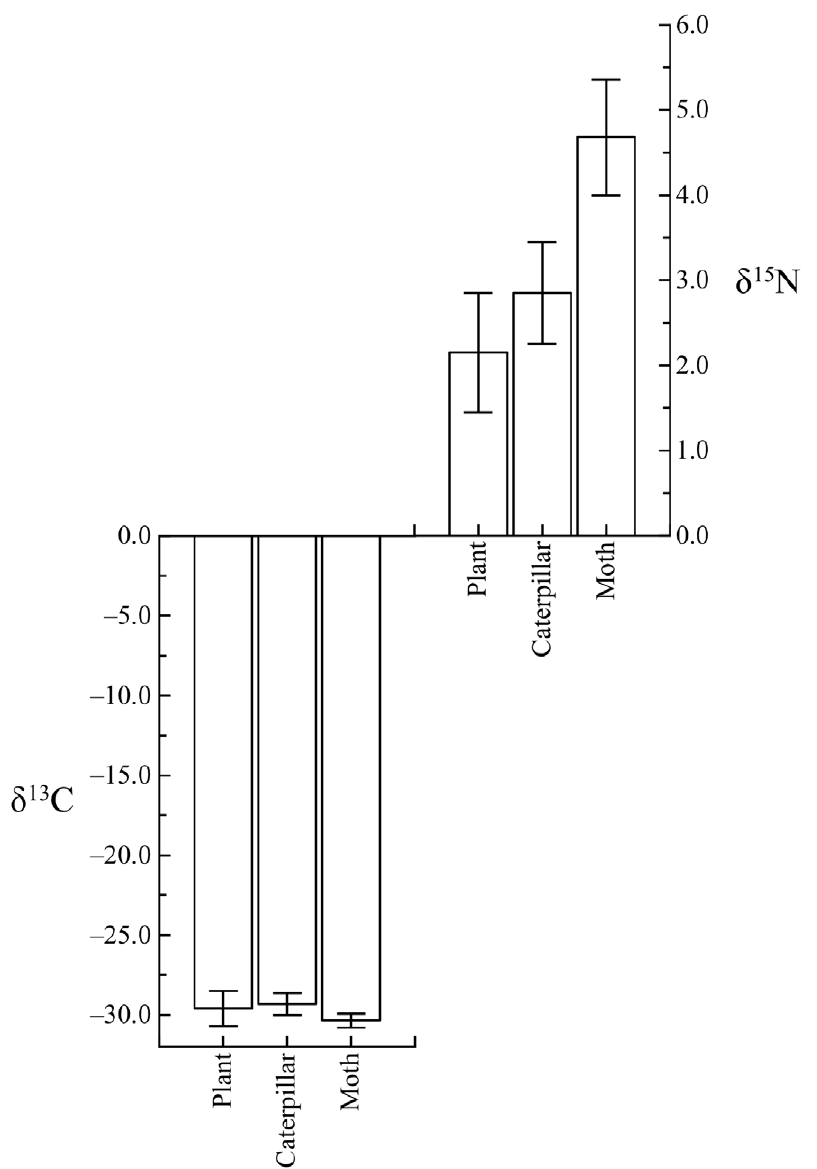
Figure 5. Carbon and nitrogen isotopic values of cabbage plants, caterpillars and moths were influenced by both trophic level and metamorphosis. There were no significant differences in d 13 C values among plants and caterpillars, but moths were slightly (albeit significantly) depleted in 13 C relative to both plants and caterpillars. In contrast, d 15 N values increased significantly from plants to caterpillars to moths. Error bars denote SE.